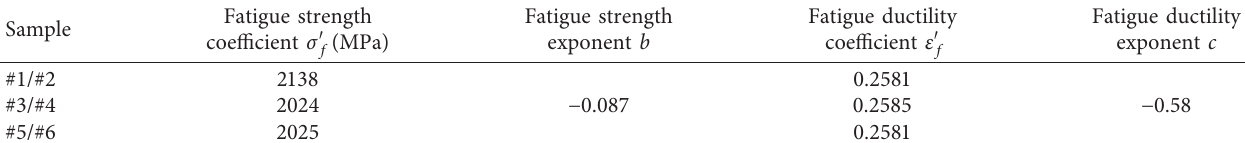
Table 4: Fatigue properties of the fastening clip material.